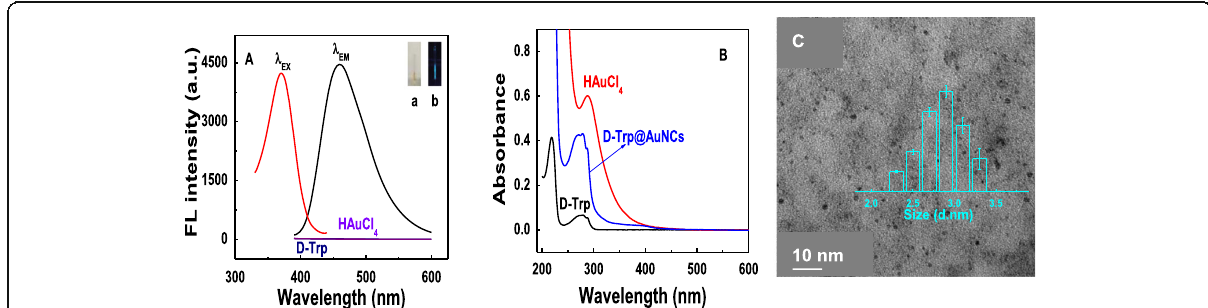
Fig. 1 ( A ) Fluorescence emission spectra of HAuCl 4 , D -Trp, and D -Trp@AuNCs, insert: photos of the D -Trp@AuNCs under (a) day light and (b) UV light. ( B ) UV-vis spectra of HAuCl 4 , D -Trp, and D -Trp@AuNCs. ( C ) TEM images of D -Trp@AuNCs; insert: particles size of D